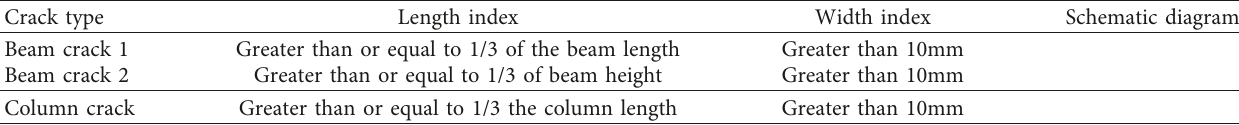
Table 2: Evaluation index of dangerous cracks